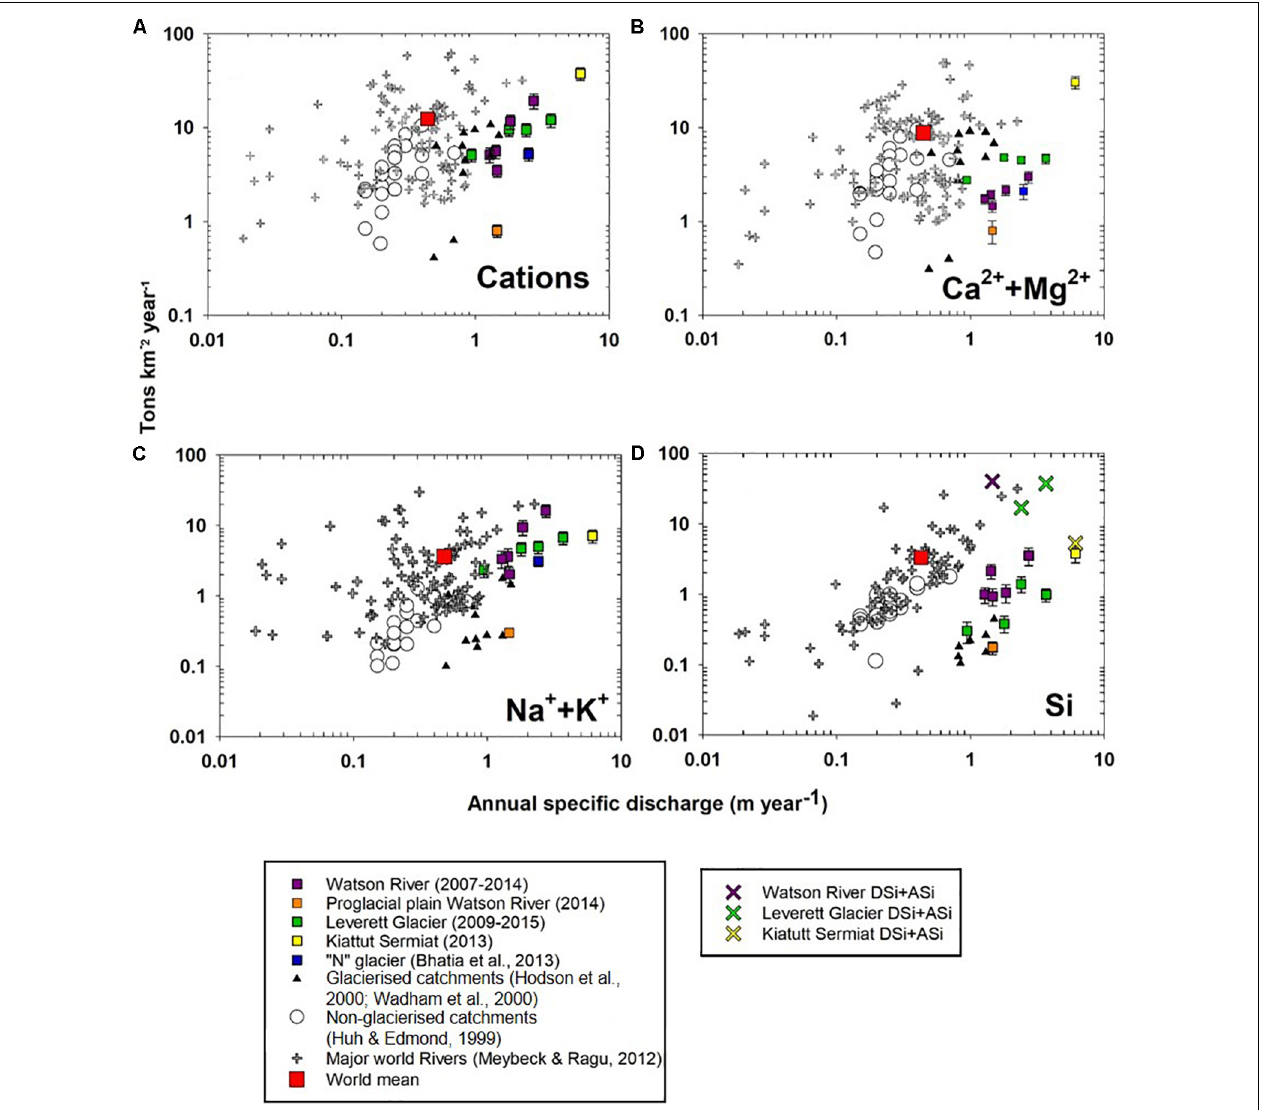
FIGURE 2 | Flux of dissolved: (A) cations, (B) Calcium + Magnesium (Ca 2 + +Mg 2 + ), (C) Sodium + Potassium (Na + +K + ) against annual specific discharge for glaciated and non-glaciated catchments, (D) dissolved silica versus annual specific discharge. For Leverett, Kiattuut Sermiat glaciers, and Watson River we plotted total silica (dissolved silica + amorphous